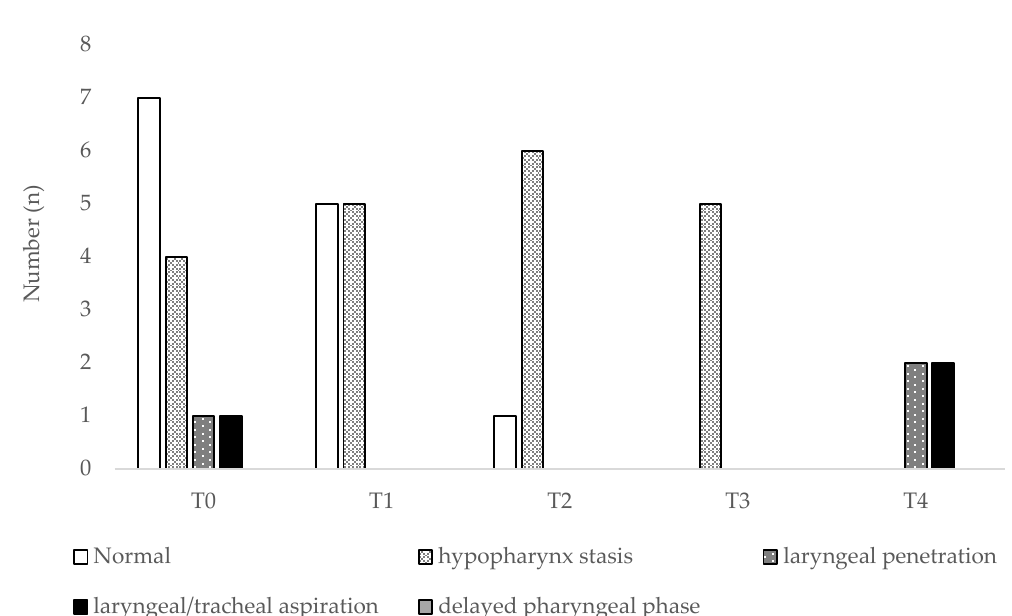
Figure 1. Fiber-optic endoscopic evaluation of swallowing (FEES) findings in Amyotrophic lateral sclerosis (ALS) spinal-onset patients. T0 stands for the evaluation at the time of diagnosis; T1, T2, T3 and T4 stand for follow-up trimesters.